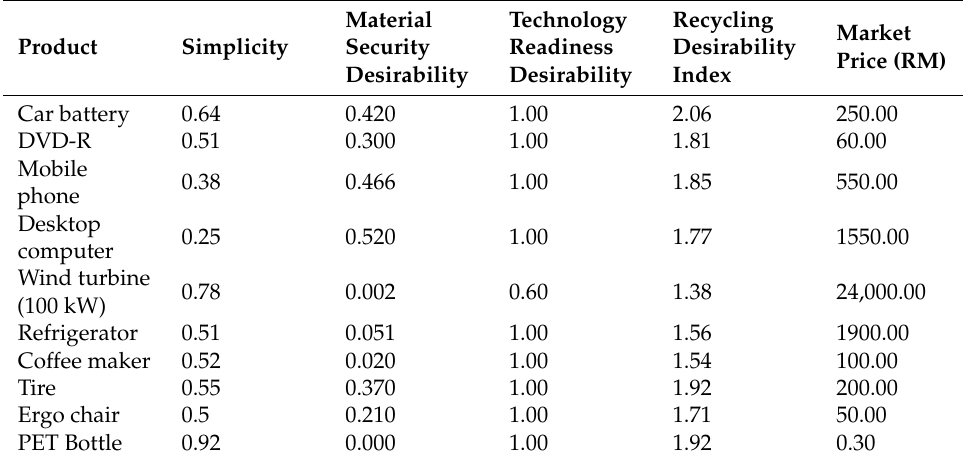
Table 9. Products Recycling Desirability Index.